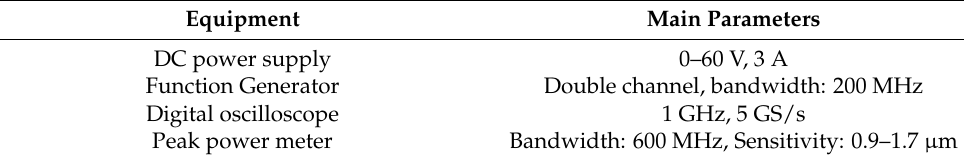
Table 2. PI test equipment and main parameters.